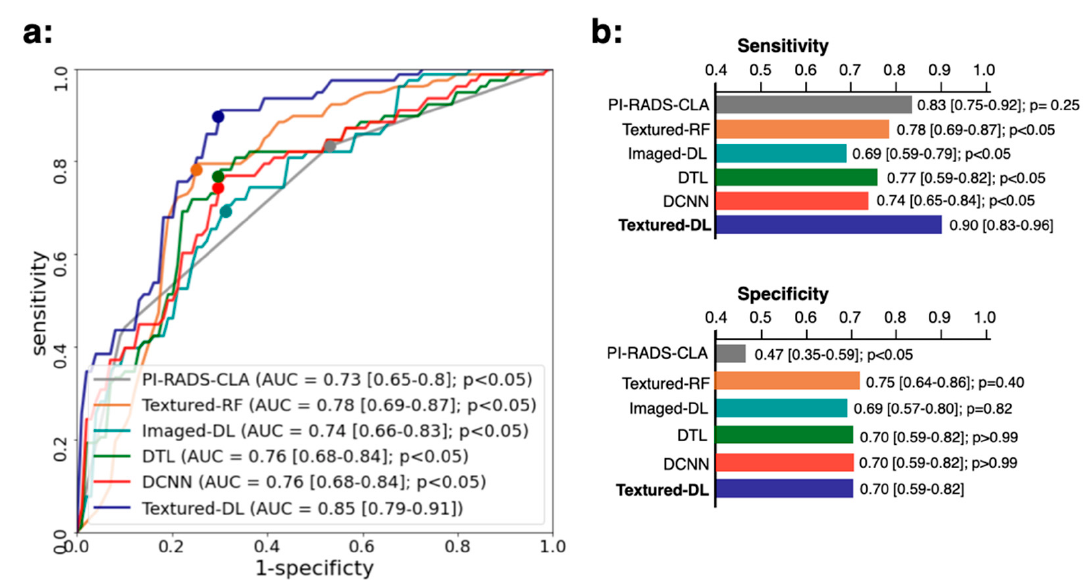
Figure 3. Comparisons of ROC ( a ), sensitivity ( b ), and specificity ( b ) between PI-RADS-CLA, Textured-RF, Imaged-RF, DTL, DCNN, and Textured-DL on the classification of PCa in the overall tumor lesions. CIs are provided in the square brackets. p values for the comparison between the baseline methods and the Textured-DL are also shown.